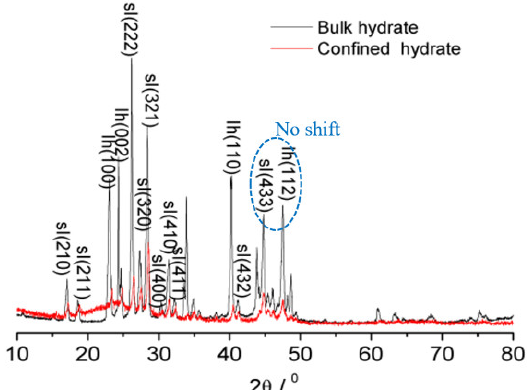
Figure 1. Powder X-ray diffraction (PXRD) patterns of the confined hydrate and bulk hydrate at 193 K. With respect to the confined hydrate, some diffraction peaks, such as sI(222), sI(320), sI(321), sI(410), etc., were shifted to the right and some diffraction peaks, such as sI(433), were not shifted to any side.